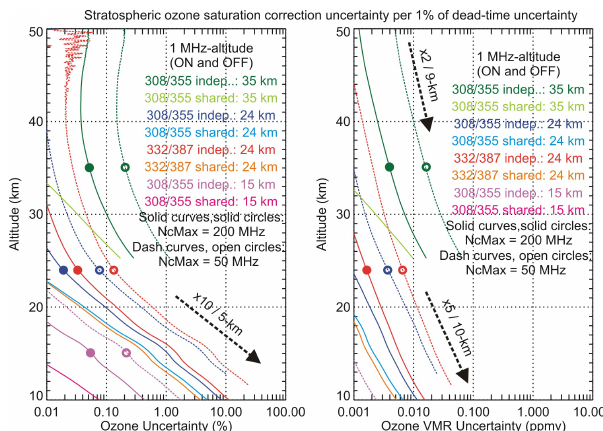
Figure 3. Ozone number density relative uncertainty (left) and ozone mixing ratio uncertainty (right) owing to saturation correc- tion for stratospheric ozone DIAL systems of varying performance. The systems’ performance is measured as the altitude of 1MHz count rate for both the ON and OFF channels signals. See text for details.